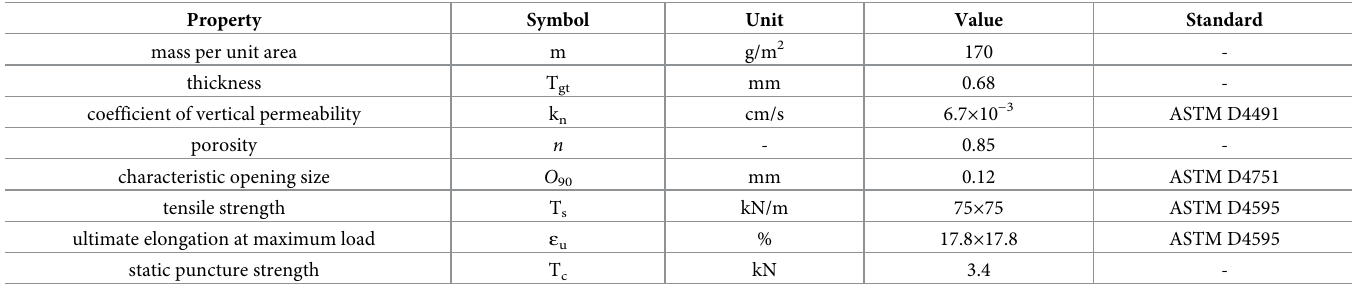
Table 1. Properties of woven polypropylene